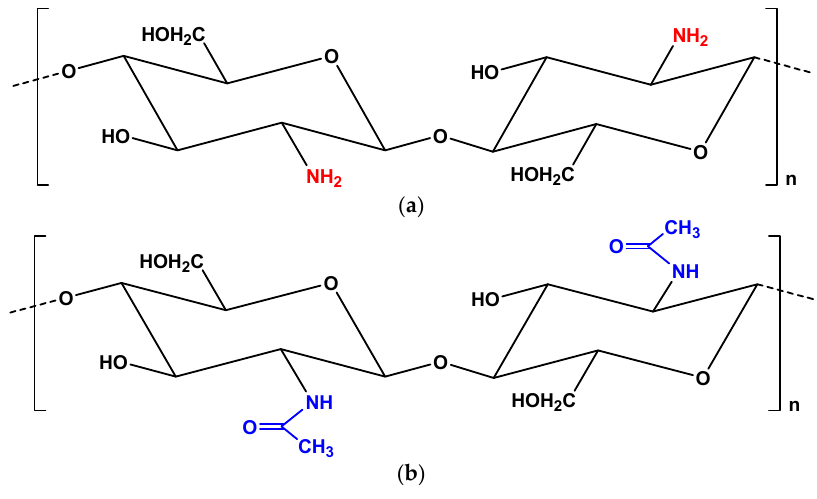
Figure 1. Chemical structure of ( a ) chitosan and ( b ) chitin.